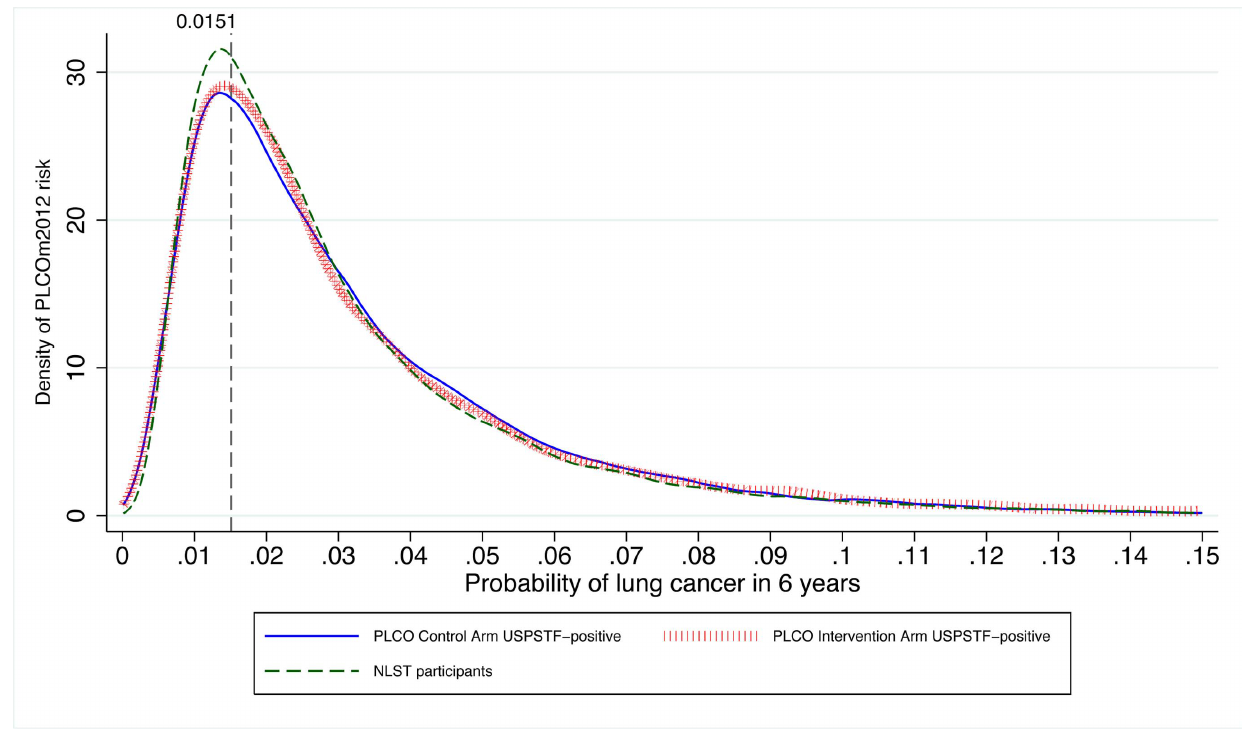
Figure 4. Distribution of PLCO m2012 risks in PLCO ever-smokers who are USPSTF-criteria-positive or are NLST participants. The vertical line indicates the PLCO m2012 risk $ 0.0151 threshold. The graph is right-truncated. PLCO m2012 is the lung cancer risk prediction model described in [11].